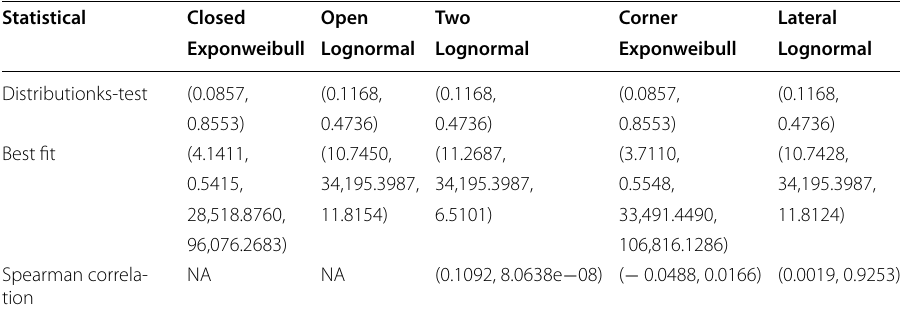
KS test and Spearman correlation: (value, p‑value). Estimated parameters of best fit: (parameters, loc, scale). The exponentiated Weibull (exponweibull) distribution shows a probability density function of the